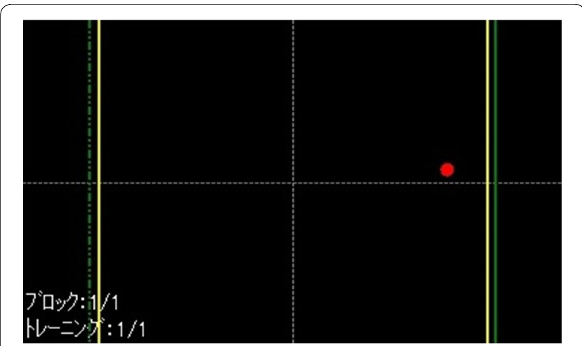
Fig. 2 Screen shot of the software. On the software screen, the CoP and target weight bearing could be displayed in real